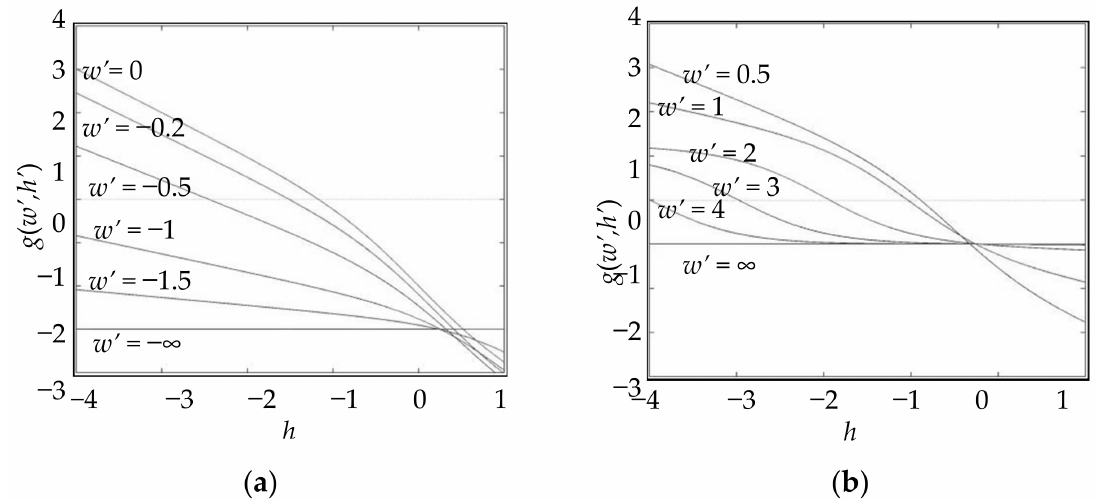
Figure 2. When σ = tanh, the curve g ( w (cid:48) , h (cid:48) ) monotonically decreases: ( a ) when h (cid:48) < 0.3 and w < 0, lim g ( w (cid:48) , h (cid:48) ) = − 1. When the conditions ( σ = tanh, h (cid:48) < 0.3, w (cid:48) < 0, and y label > 3) are met, ( b ) when h (cid:48) < − 0.3 and w > 0.5, lim w → ∞ the algorithm has the possibility of